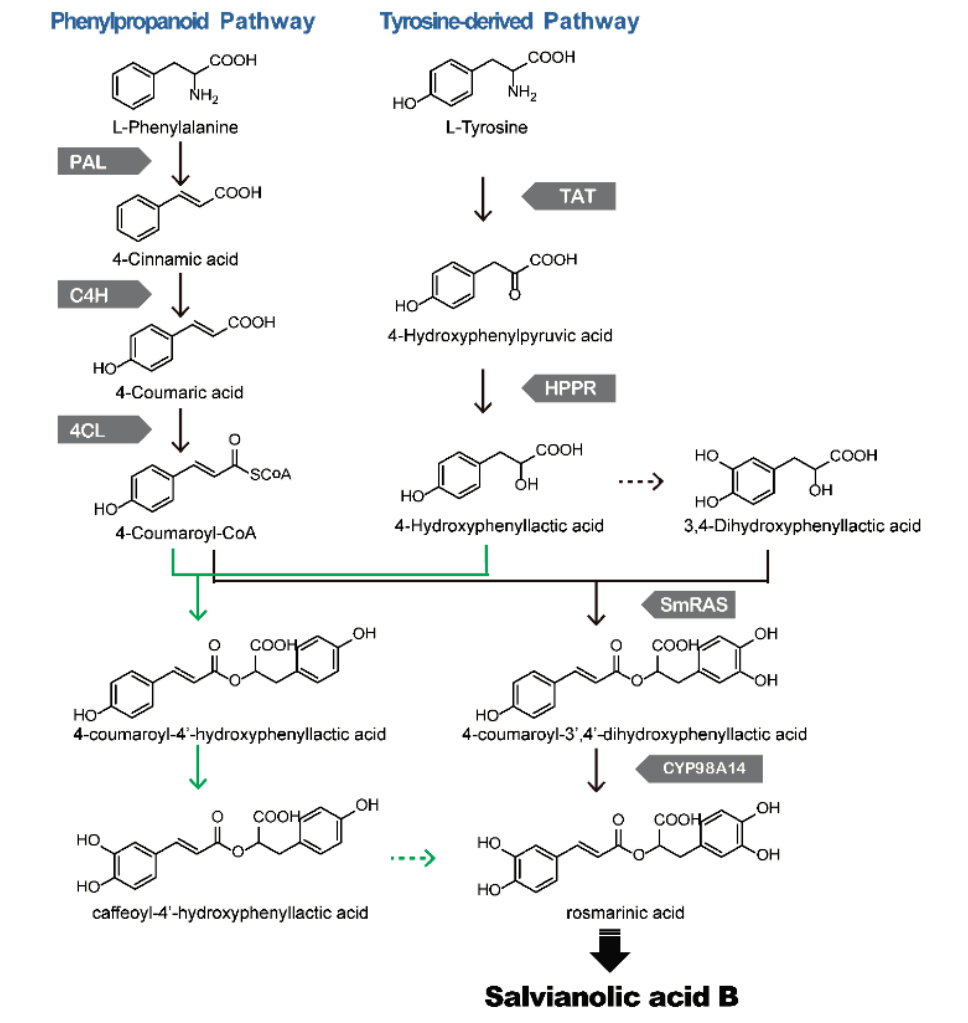
Figure 2. Biosynthethsis of phenolic acids in S. miltiorrhiza [15]. Solid arrows indicate the established relationships, and dashed arrows indicate hypothetical relationships. RA is mainly biosynthesized from the pathway showed with black arrows in S. miltiorrhiza , and part is from the pathway showed with green arrows. PAL: phenylalanine ammonialyase, C4H: cinnamic acid 4-hydroxylase, 4CL: 4-coumaroyl: CoA ligase, TAT: tyrosine aminotransferase, HPPR: 4-hydroxyphenylpyruvate reductase, RAS: rosmarinic acid